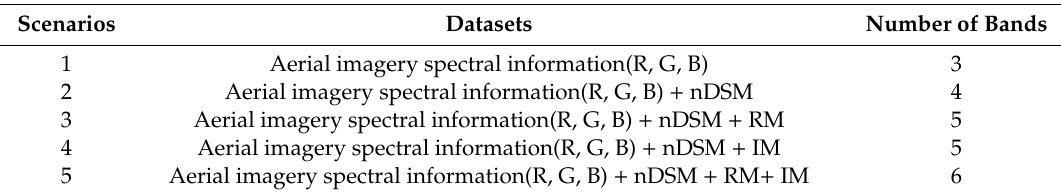
Table 1. Fused datasets input bands used for five combination scenarios.